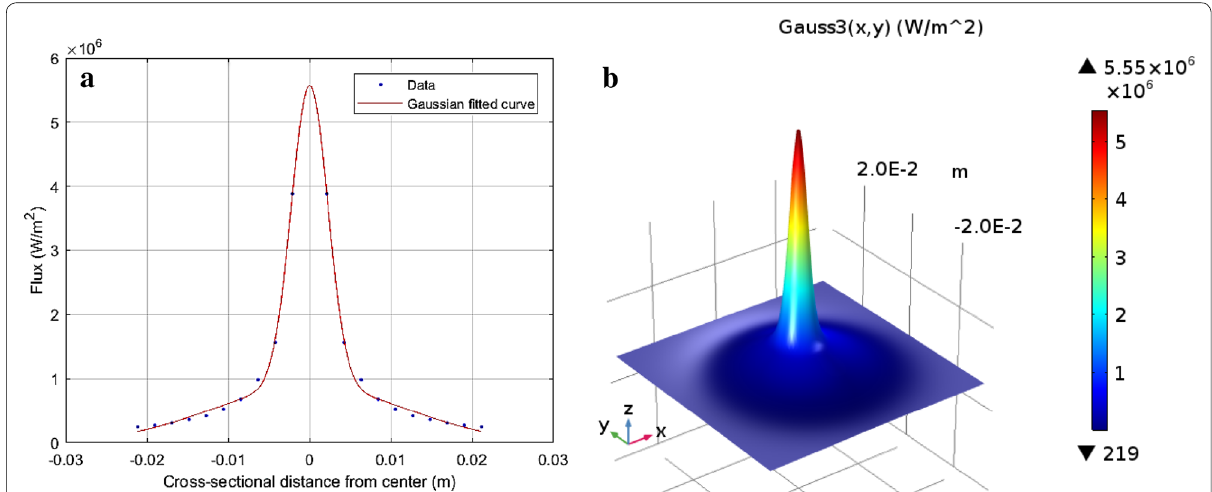
Fig. 4 Focal Heat Flux Distribution in W/m 2 for the solar welding application. a Symmetrical real-data points and 2D third-order Gaussian regression from Qandil and Zhao (2018), b 3D third-order Gaussian plotted against receiver dimensions with COMSOL ®